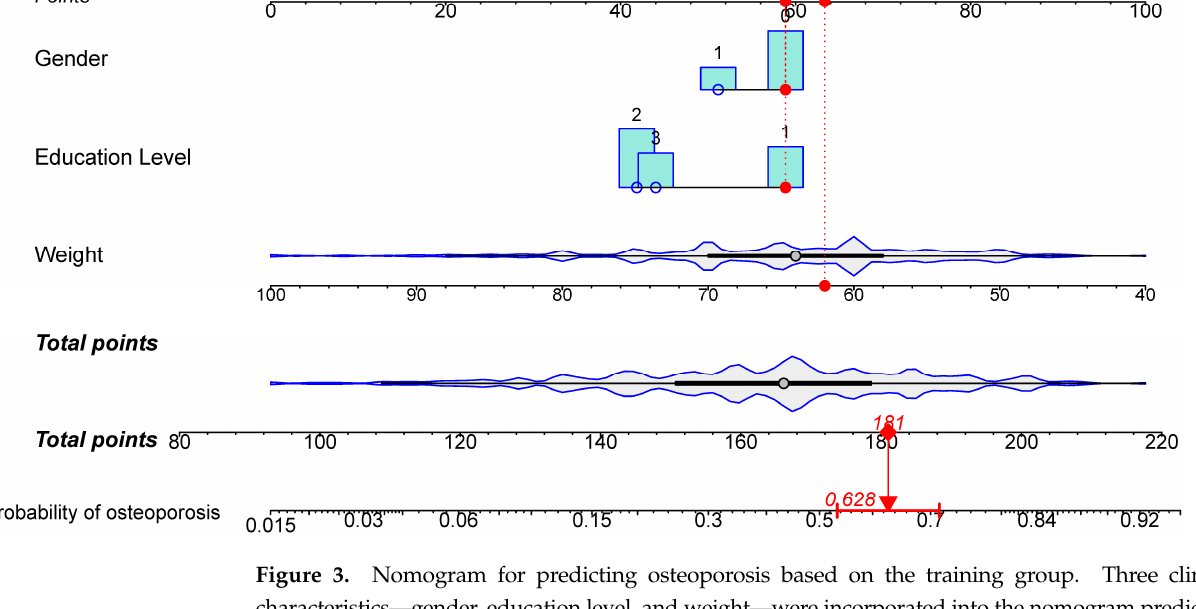
Figure 4. Dynamic Nomogram for predicting osteoporosis based on the training group. The Dynamic Nomogram can be used on computers and any mobile device. The specific link was: https://shibaolu.shinyapps.io/DynamicNomogram/ accessed on 22 December 2022. Here, the three specific clinical characteristics of the clinical subjects can be set via the parameter box on the left. When the “Predict” button was clicked, the predicted probability and 95% confidence interval for osteoporosis for this clinical subject can be displayed in the “Graphical Summary” box on the right.